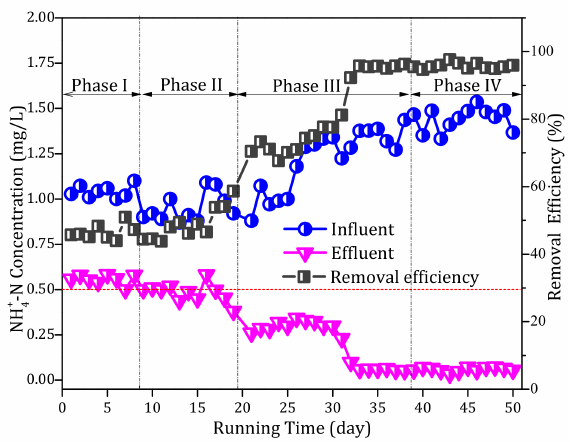
Figure 2. Profiles of the ammonium (NH 4 + ) removal performance over the continuous operational period of the pilot filter